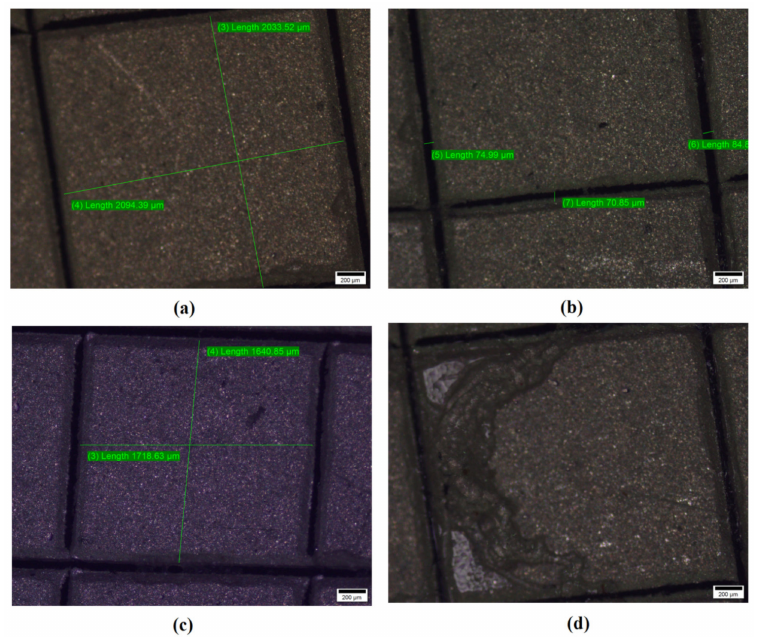
Figure 9. Specimen and tools Simulation ( a ) Grid (2 × 2 mm) ( b ) Grid verification ( c ) Depth of cut Verification ( d ) Adhesive on Coating.